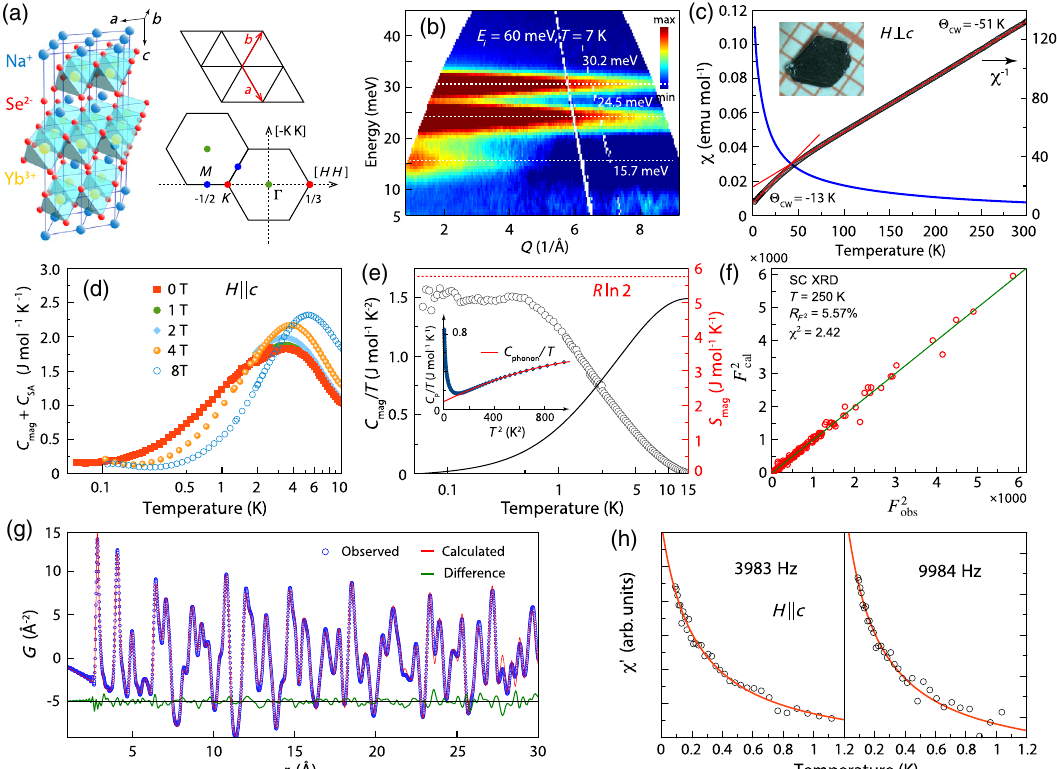
FIG. 1. Crystal structure and reciprocal space, CEF levels, heat capacity, and stoichiometry of NaYbSe 2 . (a) The structure of NaYbSe 2 and corresponding reciprocal spac. The lattice parameters are a ¼ b ≈ 4 . 07 Å, c ≈ 20 . 77 Å. (b) Inelastic neutron scattering spectra of CEF excitations obtained by subtracting the scattering of a nonmagnetic reference NaYSe 2 from the intensity of NaYbSe 2 (see the Appendix), in which the energy axis of NaYSe 2 was shifted by − 1 . 7 meV for calibrating the difference in phonon energies [38]. Three CEF energy levels are marked by white dashed lines. (c) Temperature-dependent magnetic susceptibility along H ⊥ c direction. The Þ − 1 for high-temperature range ( ∼ 160 – 300 K) results in a Curie-Weiss temperature Θ ≈ fitting ð 1 = χ − χ 0 Þ ¼ ð C=T − Θ CW ; ⊥ CW ; ⊥ − 51 K, and the low-temperature range ( < 20 K) generates a Θ ≈ − 13 K, in which C is Curie constant, and χ ∼ 2 × 10 − 4 emu/mol 0 CW ; ⊥ is a temperature-independent background term. The inset shows the crystal for the magnetization measurements. (d) Temperature- dependent magnetic contribution ( C ) to the specific heat (with minor contribution from nuclear Schottky anomaly C ) of NaYbSe 2 mag SA =T and its dependence on applied magnetic fields H k c [38]. Phonon contribution has been subtracted. (e) Temperature-dependent C mag =T subtracted [38] and the magnetic entropy (black curve). The red dashed line marks the value of R ln 2 . The (black circle) with C SA inset shows C p =T as a function of T 2 . The red solid curve is a fitting of the phonon contribution C . (f) The Rietveld refinement phonon results of the single-crystal x-ray diffraction (SC XRD) data at 250 K yield Na 0 Yb 0 YbSe 2 . F 2 and F 2 are the calculated . 952 ð 10 Þ . 048 ð 10 Þ cal obs and observed structure factors, respectively. (g) The PDF analysis of neutron data on NaYbSe 2 up to 30 Å. The weighted residual value is 9.56%. (h) ac susceptibility of NaYbSe 2 single crystal measured with frequencies of 3983 and 9984 Hz. The red solid curves are Curie-Weiss fits for the